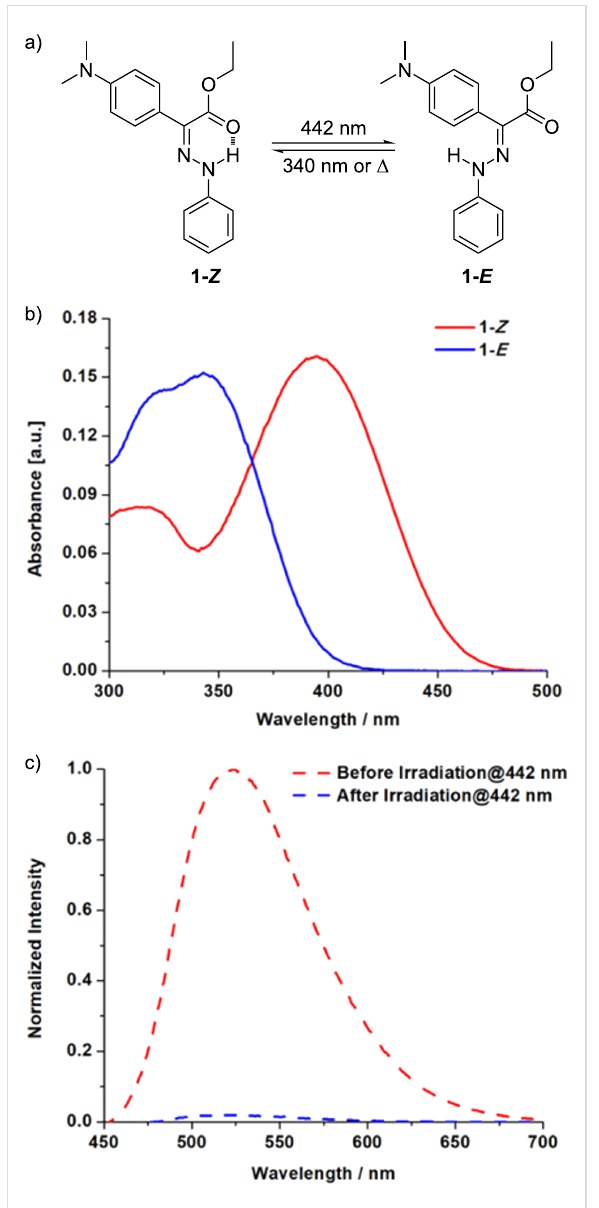
Figure 1: a) The photoinduced Z / E isomerization of hydrazone 1 , and accompanied changes in b) UV–vis absorption (1 × 10 − 5 M; toluene) and c) fluorescence emission spectra (1 × 10 − 6 M; toluene) before (red) and after (blue) irradiation at 442 nm.